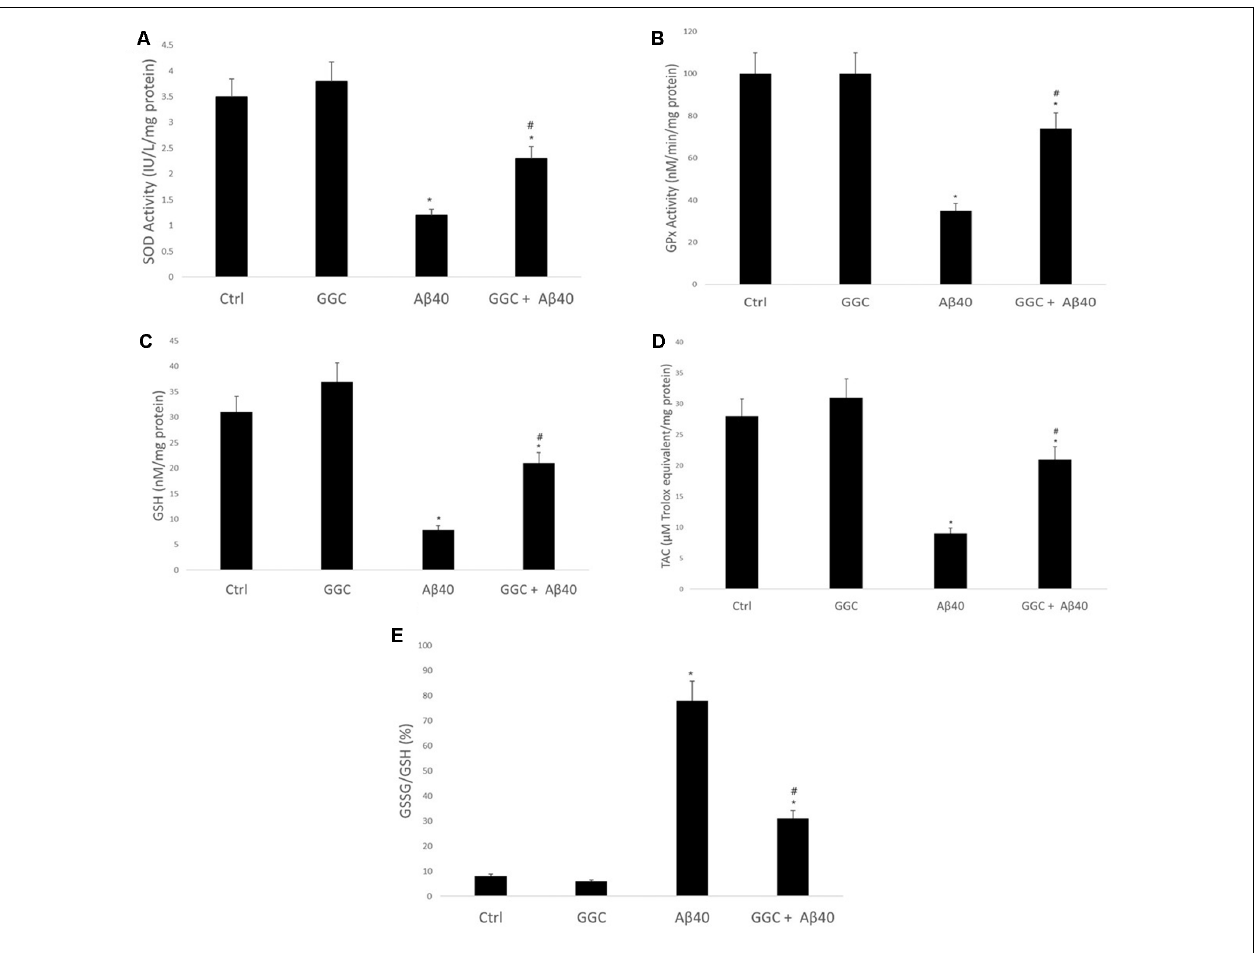
FIGURE 3 | GGC increases (A) SOD and (B) GPx activities and (C) total antioxidant capacity, (D) attenuates oligomeric A β 40 -mediated GSH depletion, and (E) decreases the GSSG/GSH ratio in isolated adult astrocytes. Significance ∗ p < 0.05 compared to control non-treated cells. # p < 0.05 compared to control cells treated with oligomeric A β 40